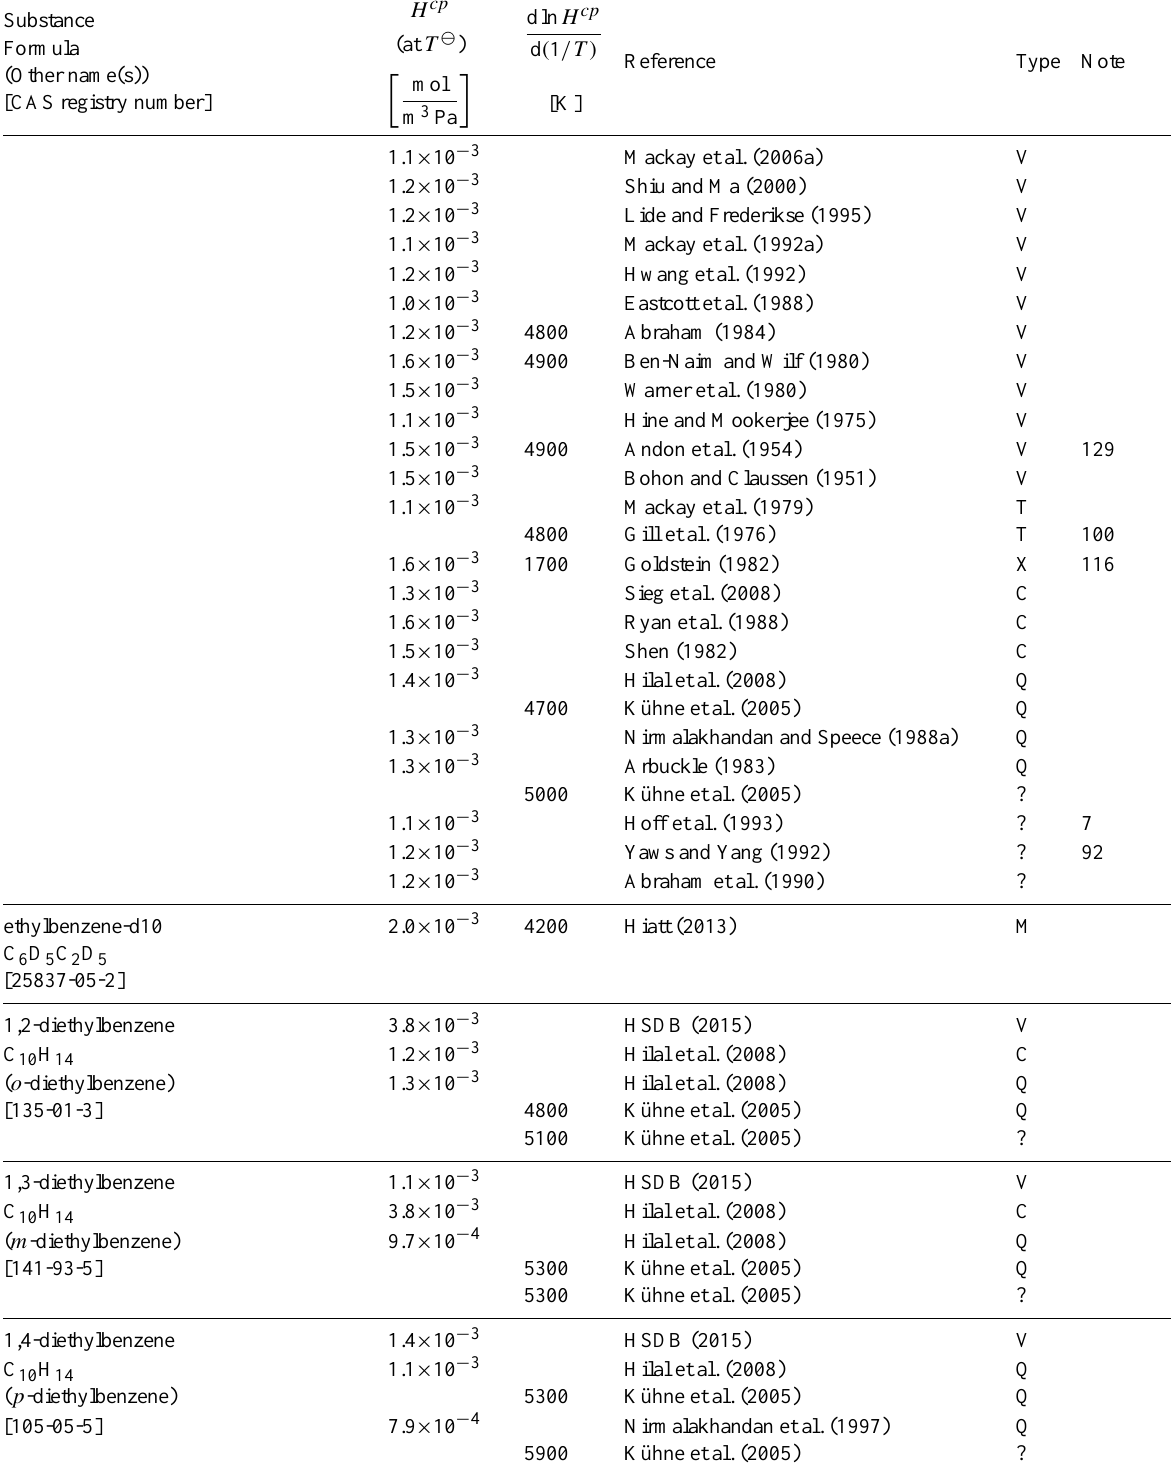
Table 6: Henry’s law constants for water as solvent